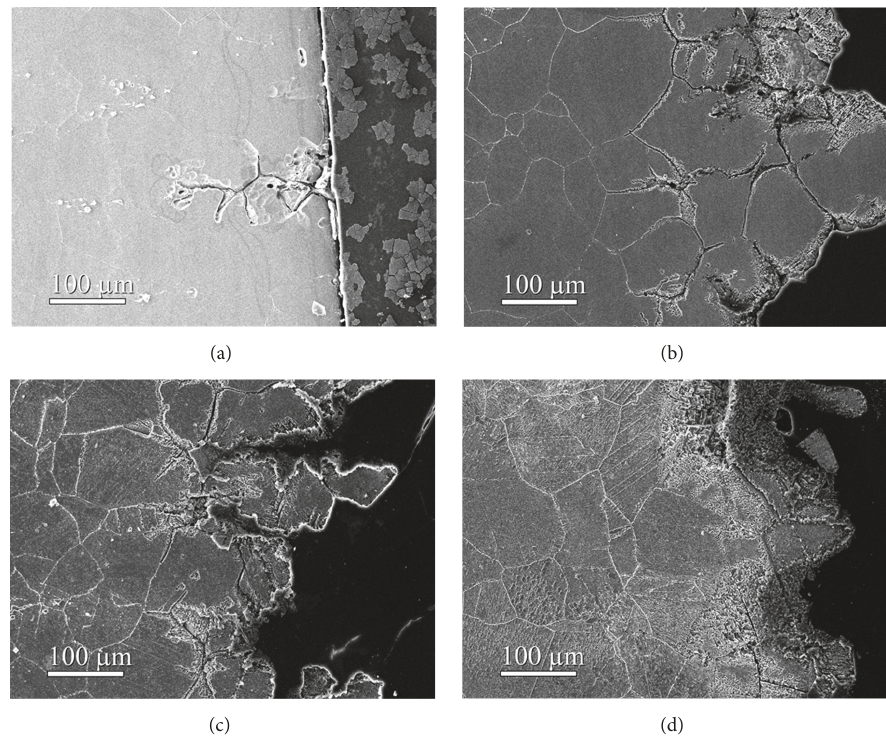
Figure 7: SEM images of the cross-sections in the Alloy 625 after for (a) 0h, (b) 40h (c), (e) 200h, and (d),(f) 1000h after 120 h ferric sulfate- sulfuric acid corrosion test.